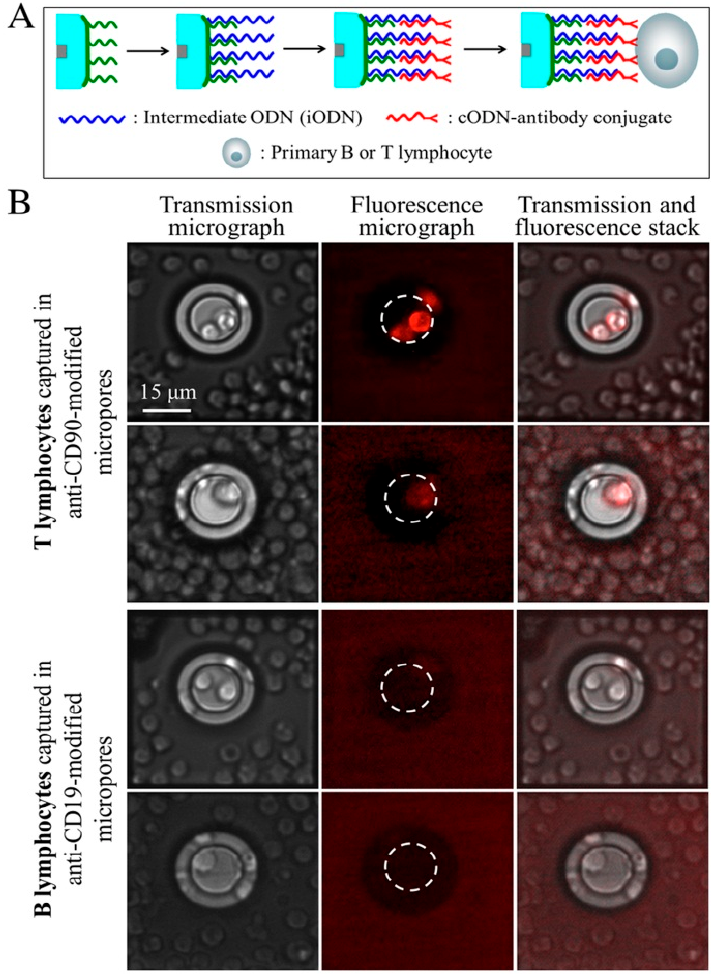
Figure 9. Selective capture of B- or T-lymphocytes using CLEF specific antibody-functionalized micropores. T-lymphocytes were selectively fluorescently labeled for visualization purposes. ( A ) Schematic principle of micropore functionalization strategy. ( B ) Transmission and fluorescence microscopy images of cells captured in antibody-functionalized micropores and stacks of the images. The white dashed circles in the fluorescence images indicate the position of the micropore wall.